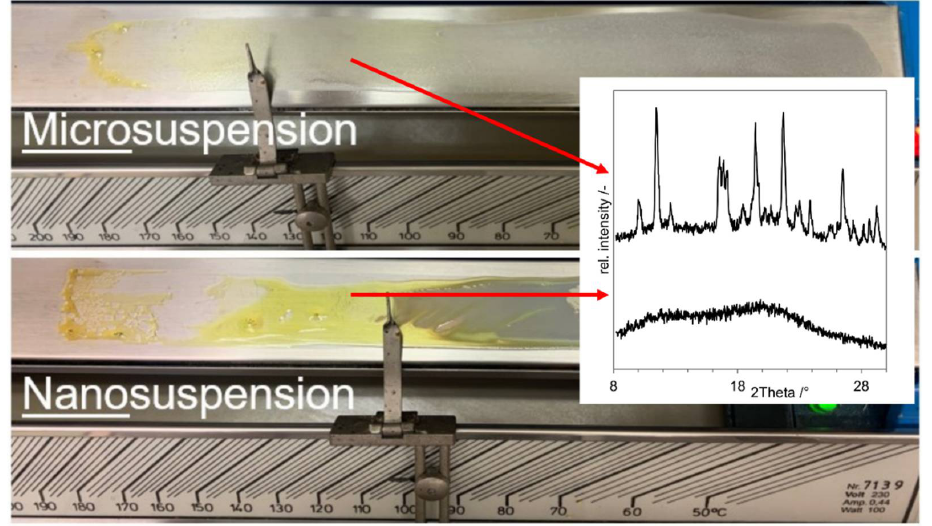
Figure 5. Kofler-bench experiments with indomethacin suspensions. The upper picture displays the result of the drying of the microsuspension. The lower picture displays the drying of the nanosuspension. The arrows indicate at which positions samples were taken. Corresponding X-ray diffractograms are shown on the right.